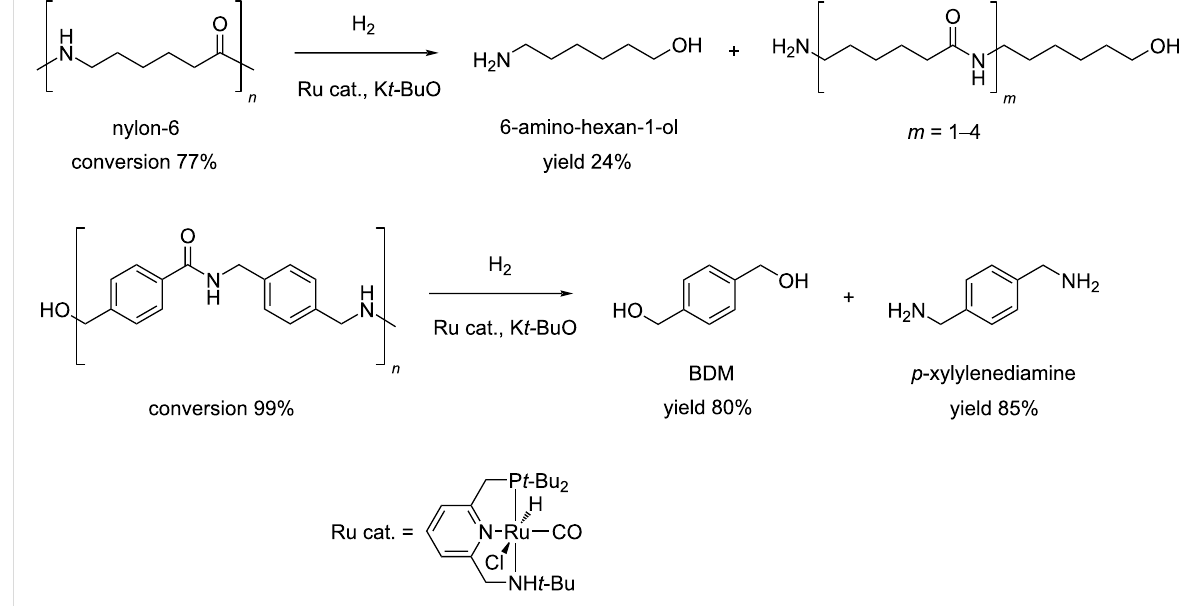
Scheme 22: Hydrogenolysis of polyamides using soluble Ru catalysts.